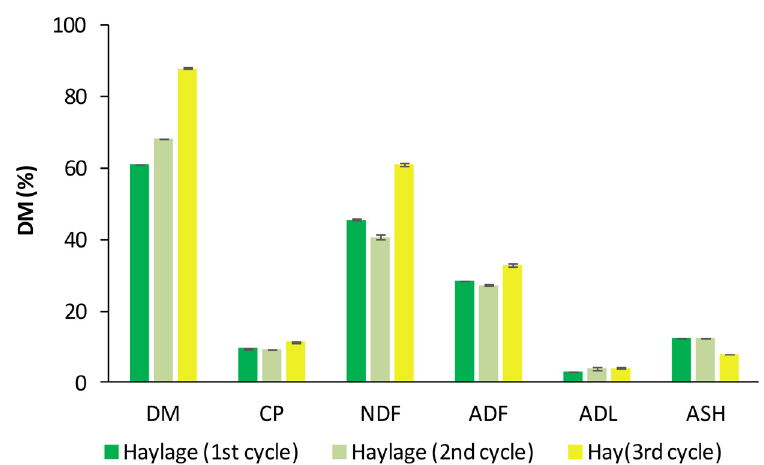
Figure 6. Chemical composition of haylage (first two cuttings) and hay (third cutting). Values are presented as mean ± SD. DM—dry-matter; CP—crude protein; NDF—neutral detergent fiber; ADF—acid detergent fiber and ADL—acid detergent lignin.